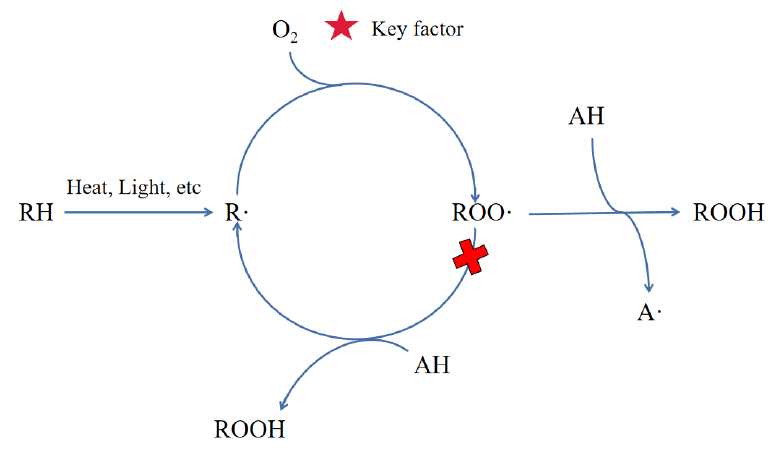
Figure 1. Thermo-oxidative aging process of RH and the anti-oxidation reaction of AH.